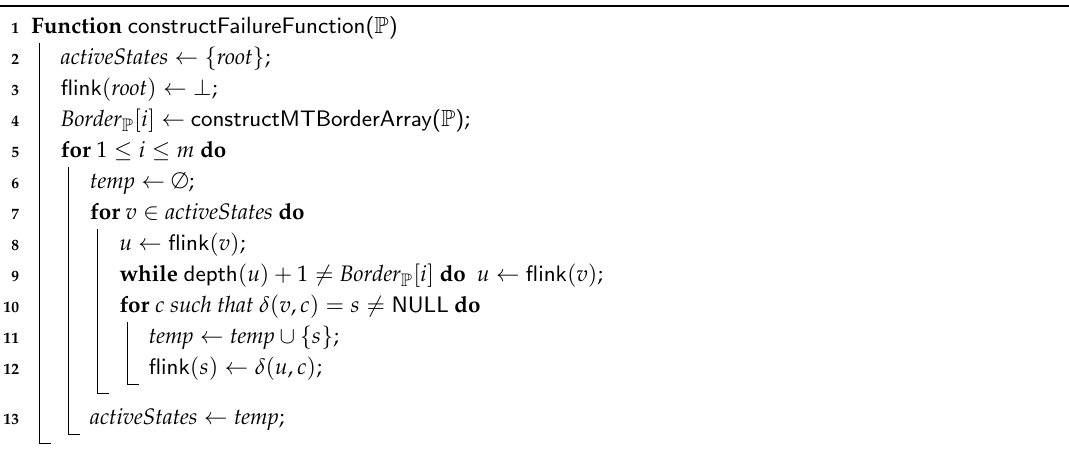
Algorithm 8: Multi-track permuted matching automaton failure function construction